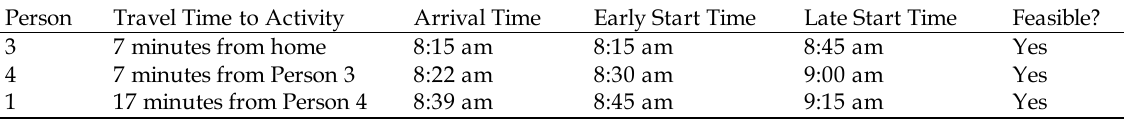
Table 4. Feasibility of Person 1 Chaperoning Persons 3 and 4